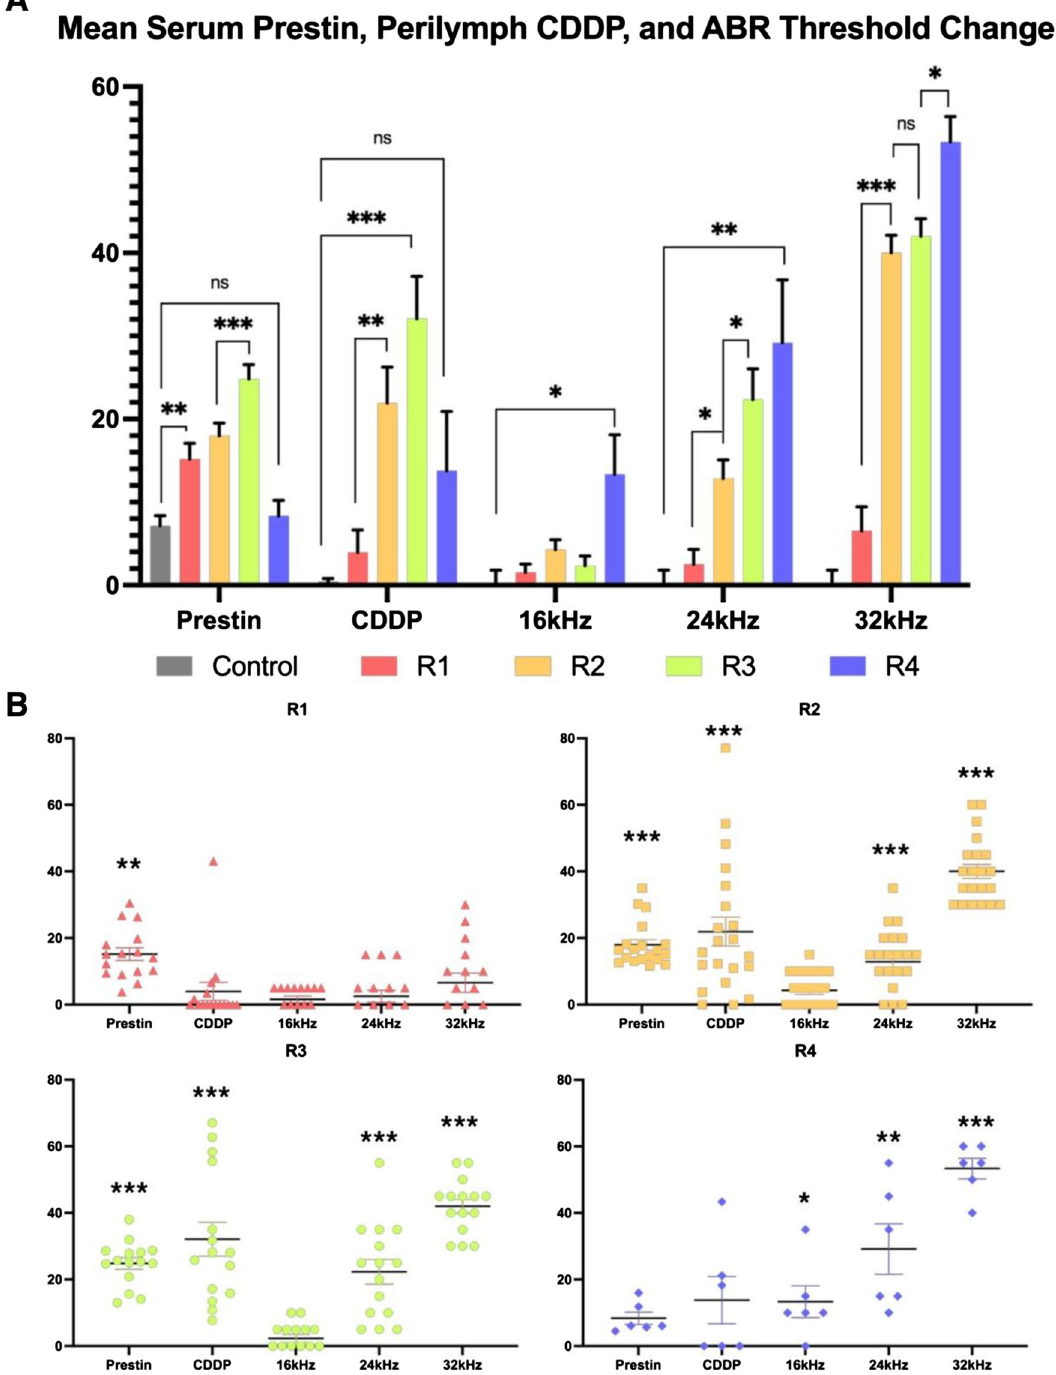
Figure 3. Serum prestin (ng/mL), cisplatin perilymph concentration (pg/mL), and ABR threshold shifts (dB) plotted together for each recovery group with comparisons shown between each group ( A ), and distributions for each recovery group plotted and compared against control ( B ). Error bars represent standard error of mean (SEM), * < 0.05, ** < 0.01, *** <